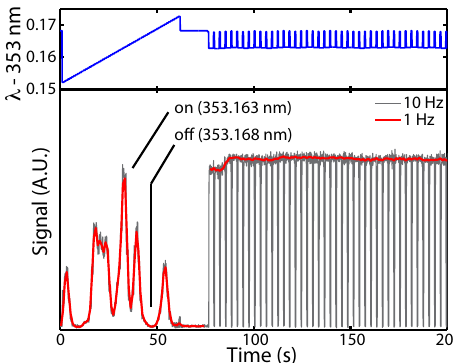
Figure 6. These plots show the wavelength (top) and fluorescence signal (bottom) during a scan of the laser, followed by the standard data acquisition mode. The computer algorithm uses the reference cell signal to maintain the laser on the large rotational feature at 353.163nm. The contributions of species other than HCHO to the fluorescence signal are removed by subtracting the signal at the of- fline position. The difference between the signal at the online posi- tion and the offline position is proportional to